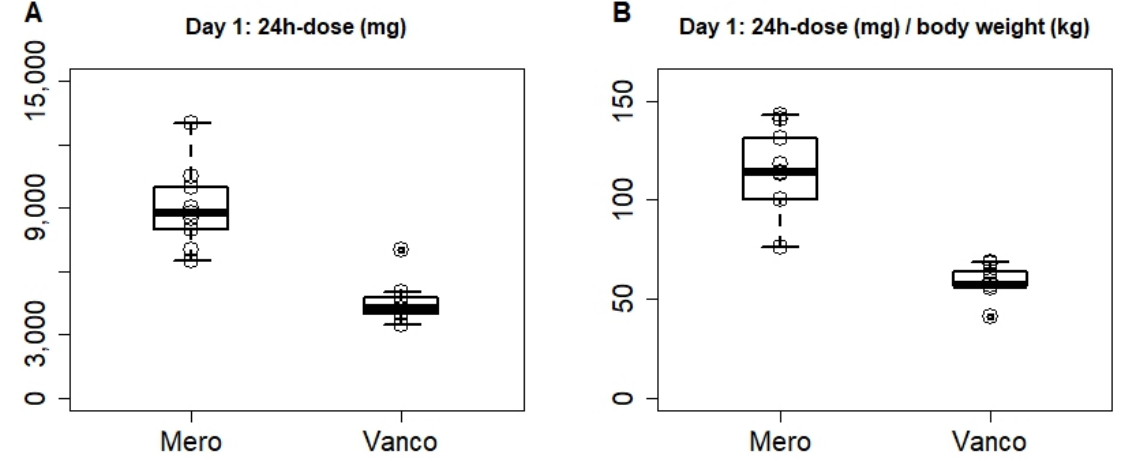
Figure 1. Applied dose of meropenem (Mero) and vancomycin (Vanco) over the first 24 h (total A , or in relation to body weight B ). Depicted are the median, and 50% quartile ranges; dots depict individual patient values (n = 9).